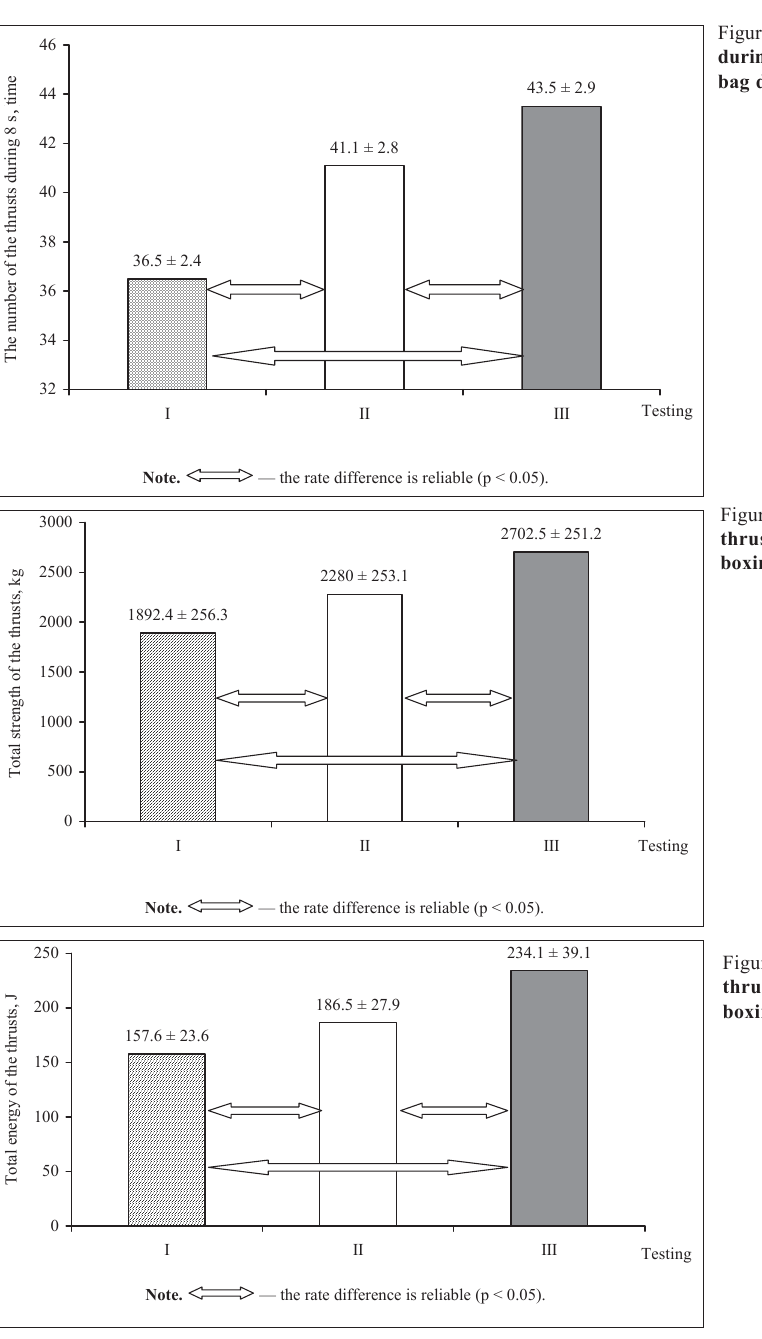
Figure 3. The alteration of the number of the thrusts during the young boxers’ 8 sec lunging to the boxing bag during the fi rst year of training ( ± SE)